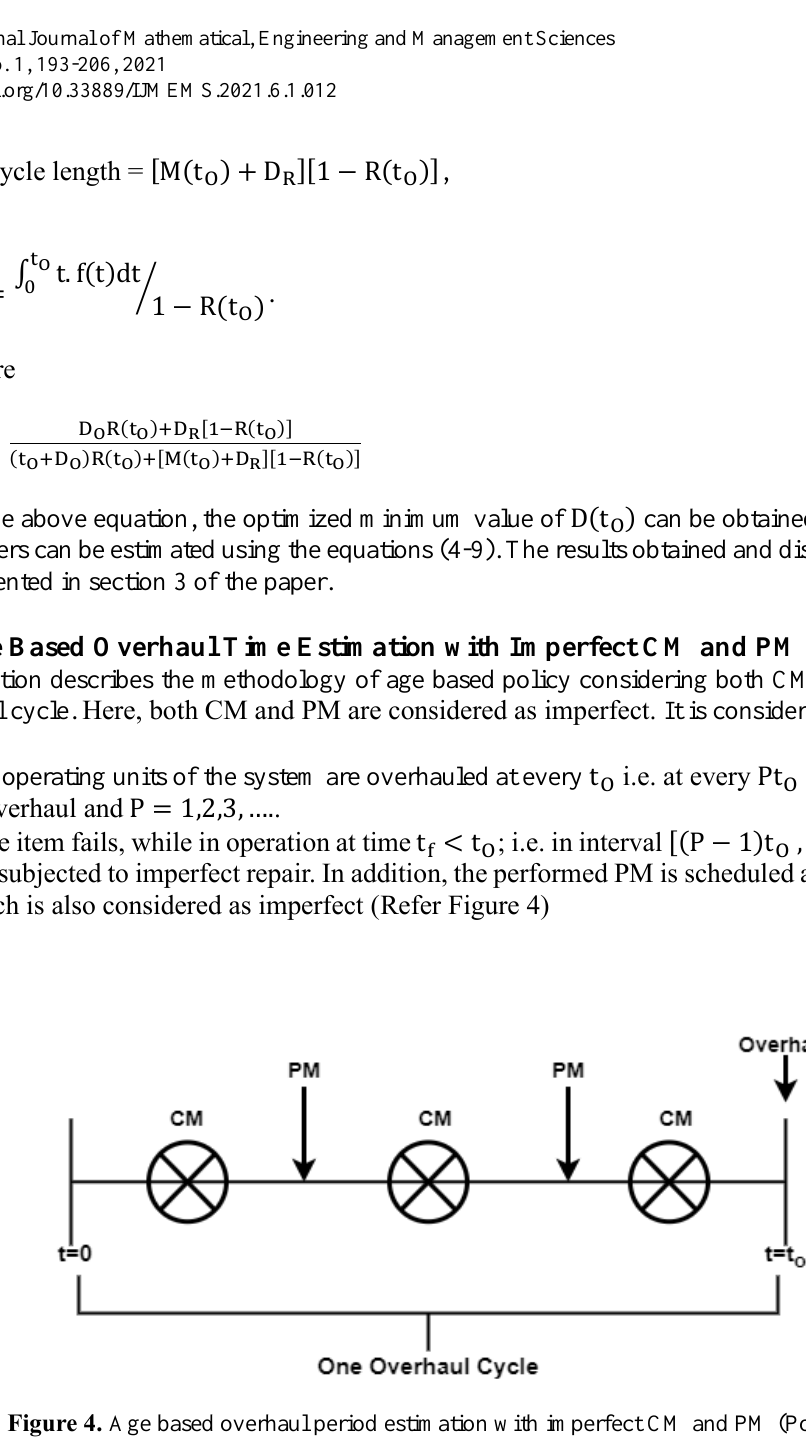
Figure 4. Age based overhaul period estimation with imperfect CM and PM (Policy